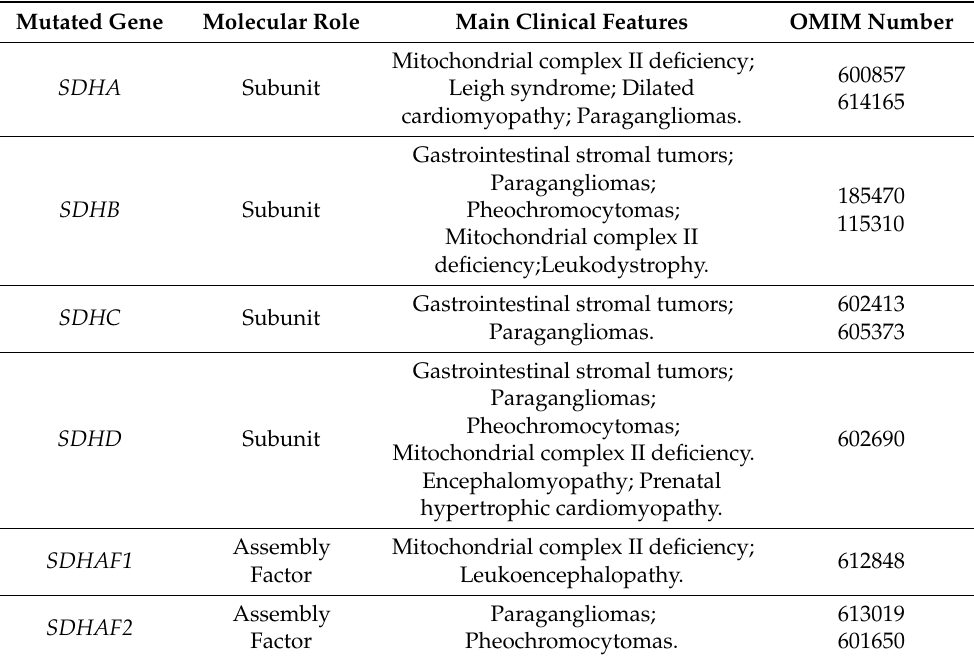
Table 2. Mutations in nuclear genes associated with mitochondrial complex II deficiency. Adapted and modified from [21].